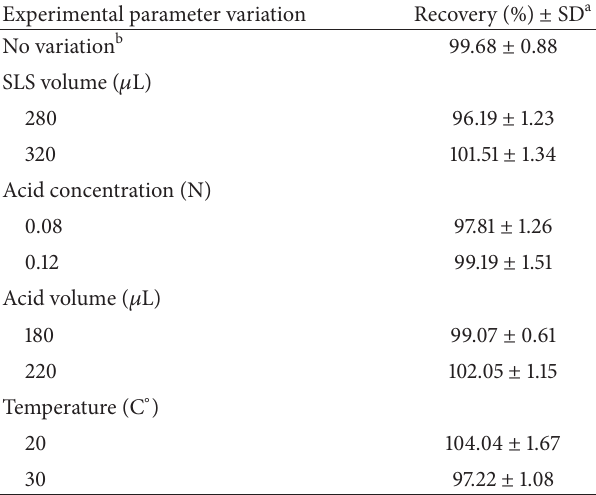
Table 4: Robustness of the proposed spectrofluorimetric method. Experimental parameter variation